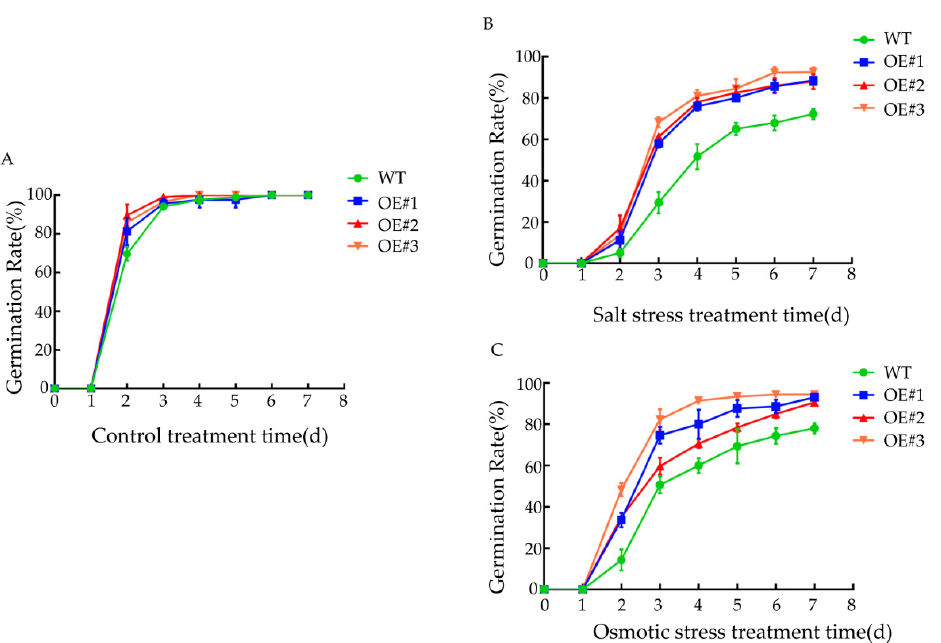
Figure 11. Effects of different stresses on the seed germination rate of transgenic Arabidopsis thaliana . ( A ) Half MS Petri dish. ( B ) Half MS Petri dish containing 150 mM NaCl treatment. ( C ) Half MS Petri dish containing 250 mM mannitol treatment.